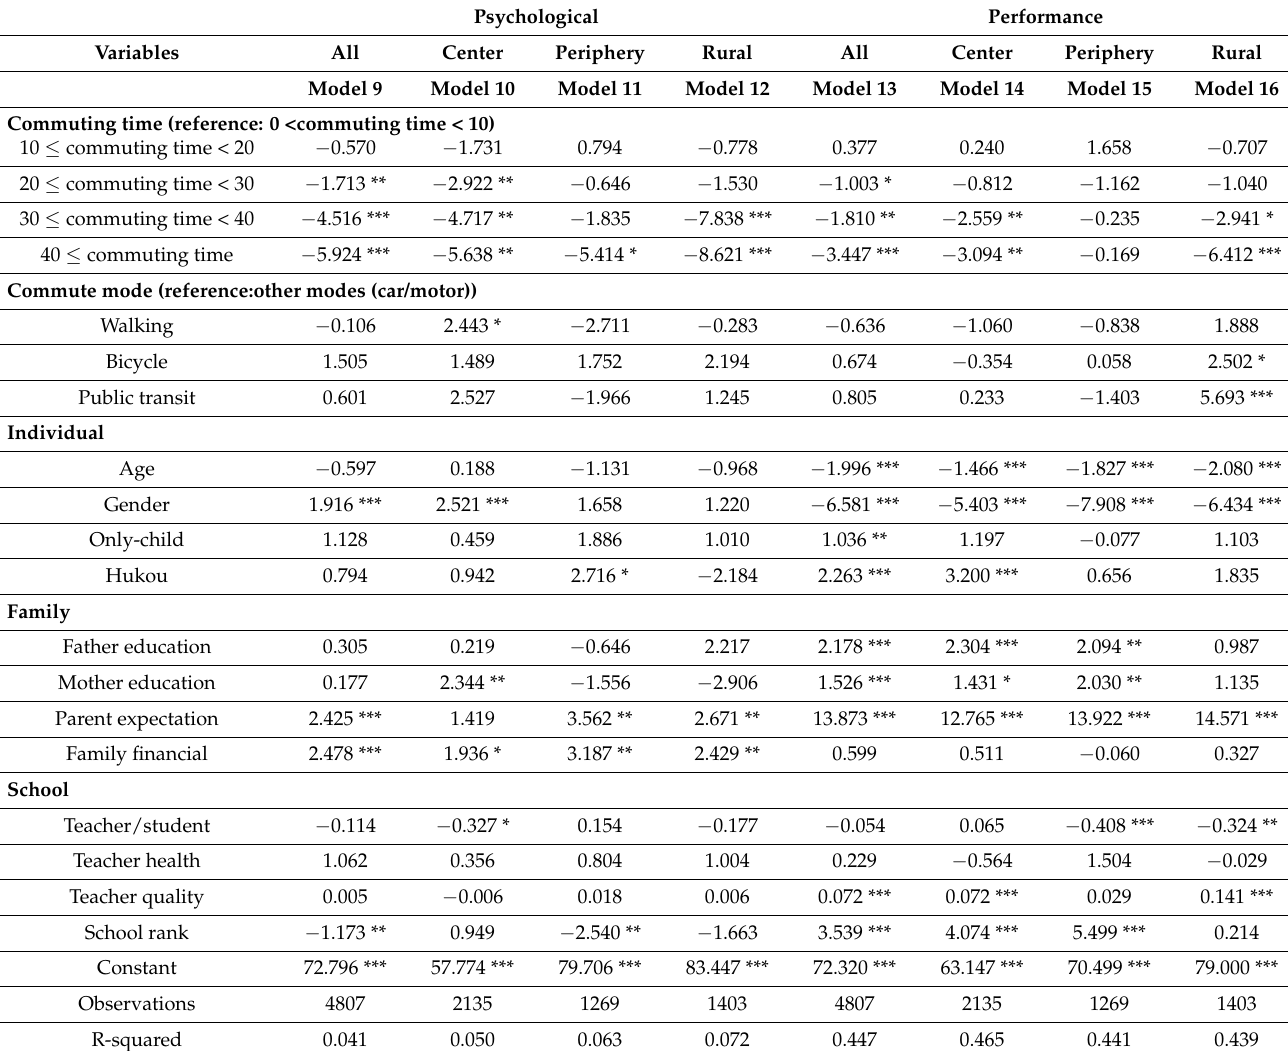
Table 4. Estimated results under different commuting